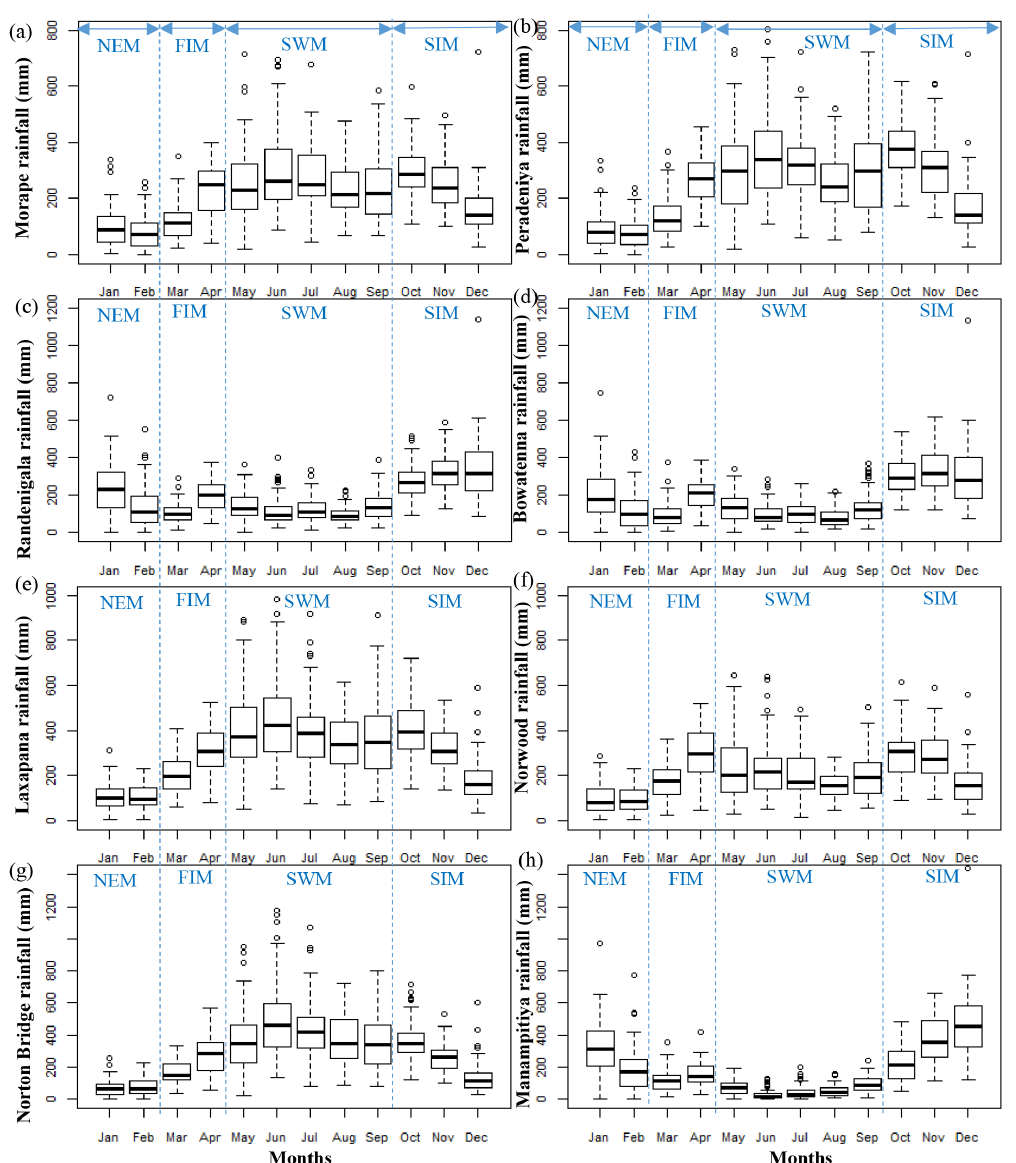
Figure 2. Subbasin rainfall for (a) Morape, (b) Peradeniya, (c) Randenigala, (d) Bowatenna, (e) Laxapana, (f) Norwood, (g) Norton Bridge, and (h) Manampitiya. Rainfall seasons are northeastern monsoon (NEM), first inter-monsoon (FIM), southwestern monsoon (SWM), and second inter-monsoon